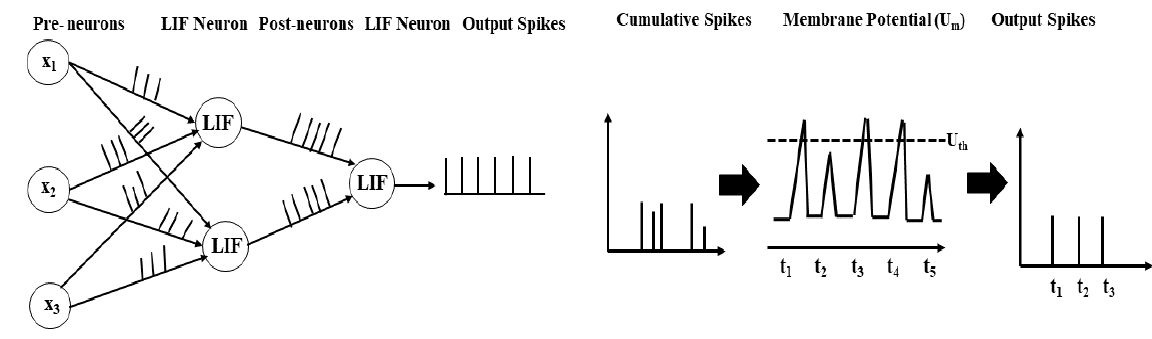
Figure 1. The spike generation mechanism of neurons in the spiking neuron model (LIF). The pre-synaptic neurons or spikes x i ( t − t k ) are controlled by interconnecting synaptic weights ( w i ) to generate post-synaptic neurons or spikes. The total input values combine into post-synaptic membrane potential ( U m ) that leaks exponentially with time and with a time constant ( τ m ) . If the neuron’s membrane potential of the pre-synaptic neurons crosses a specified threshold ( U th ) , post-synaptic spikes are generated and then rearranges its membrane potential to the starting